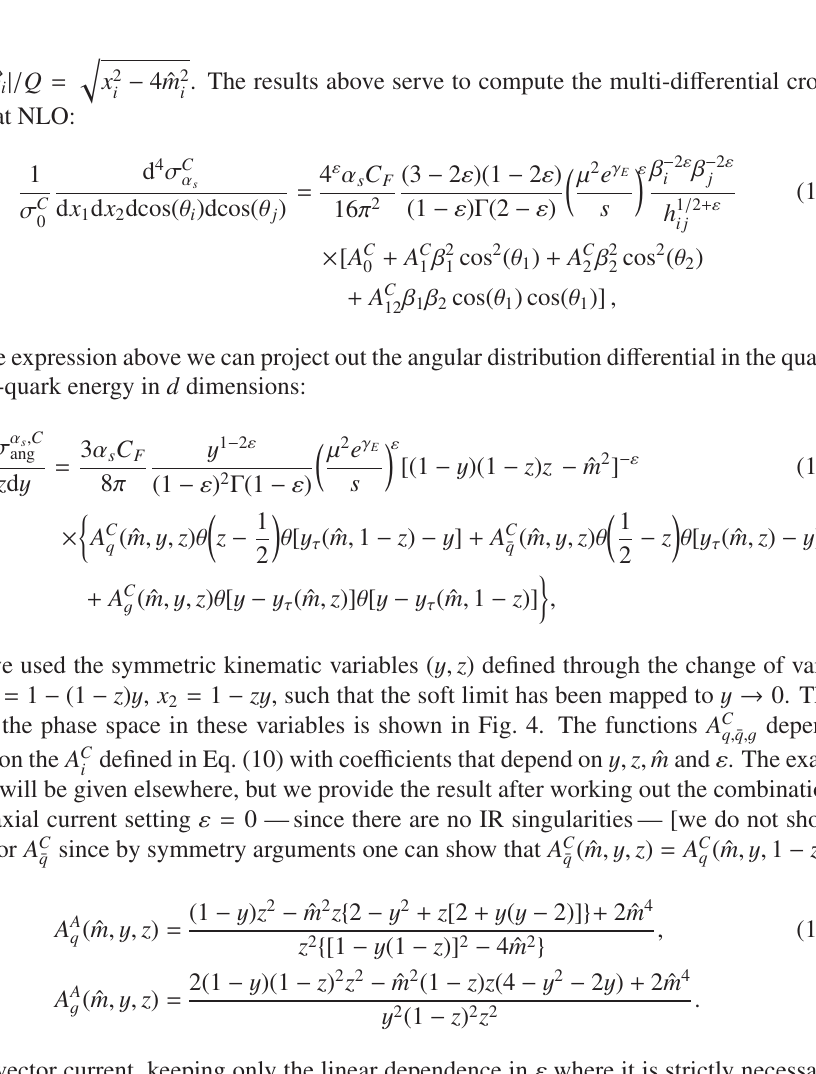
Figure 4: Phase space for three particles (two quarks with equal mass plus a massless gluon) in ( z , y )